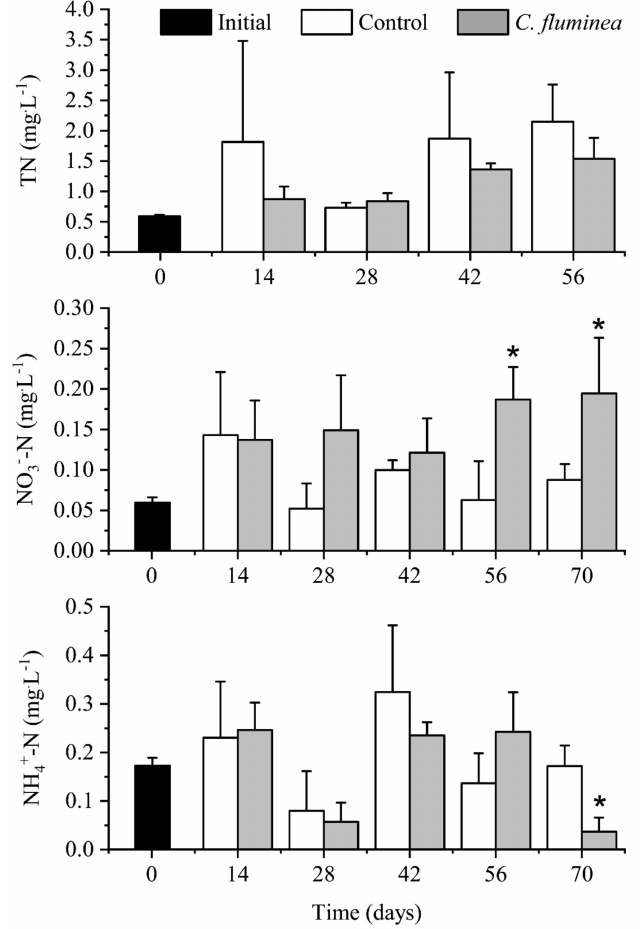
Figure 1. Total nitrogen (TN, mean ± SD), nitrate nitrogen (NO 3 − -N, mean ± SD), and ammonium nitrogen (NH 4 + -N, mean ± SD) in different treatments over time. Asterisk indicates significant differences between the treatments and controls ( p <